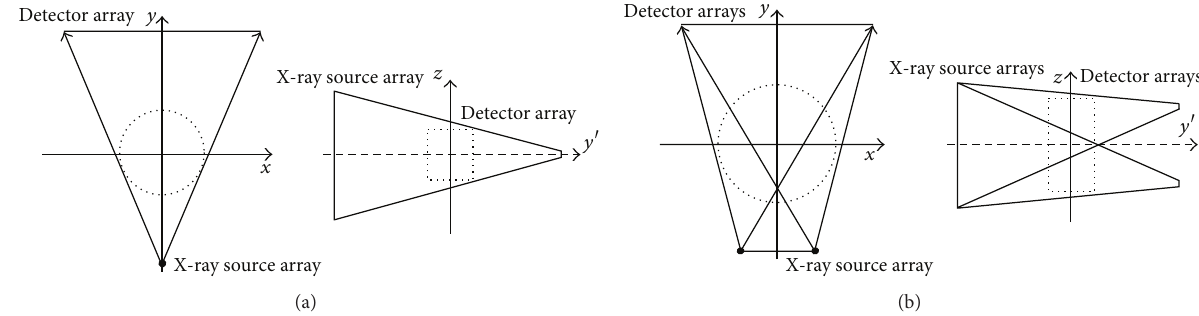
Figure 1: Single-source single-detector TBCT geometry (a). Dual-source dual-detector TBCT geometry